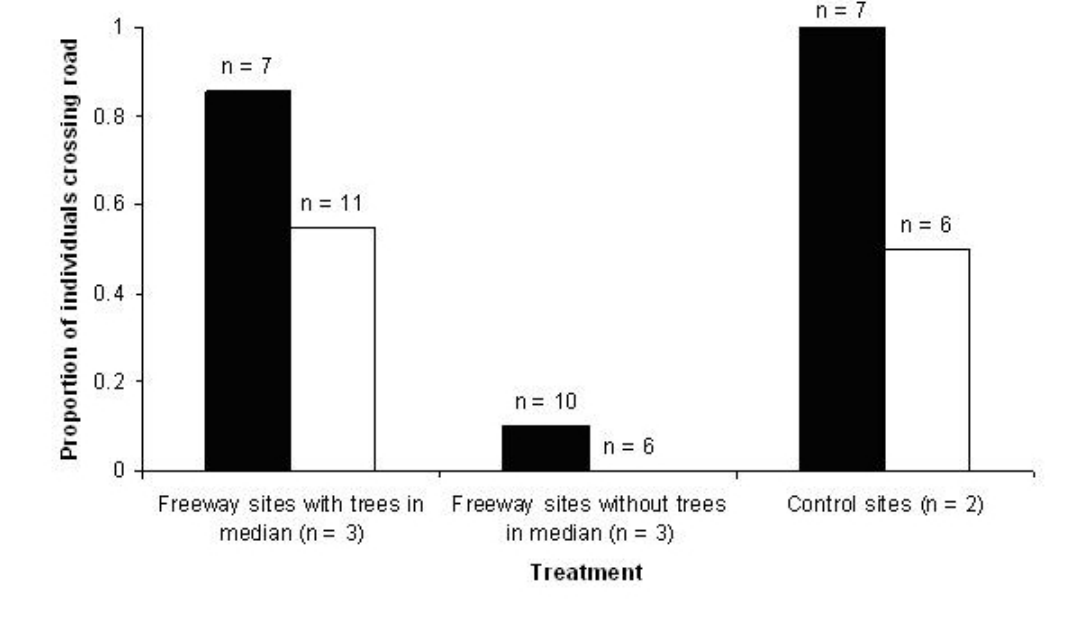
Fig. 4. Proportion of squirrel gliders ( Petaurus norfolcensis ) that were observed crossing (complete and partial crossings) the Hume Freeway or at secondary roads (control). Males are shown in black, females in clear. Number of gliders in each treatment is shown above